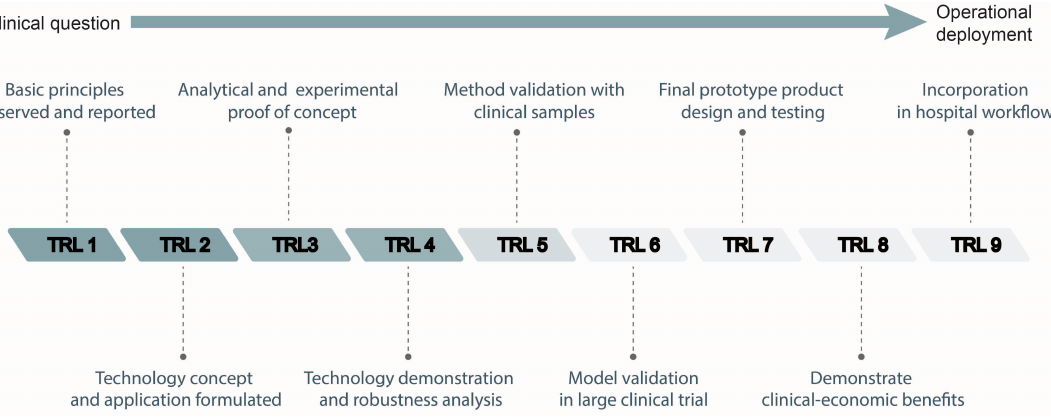
Figure 4. Roadmap for the clinical translation of SERS for TDM. The well-known technology readiness levels (TRL) reached by the SERS works reported in this review are indicated with a color intensity scale: only the first 5 levels are covered. The majority of studies are at the “proof of principle” level or the “validation of single functionality” level (TRL 3–TRL4).